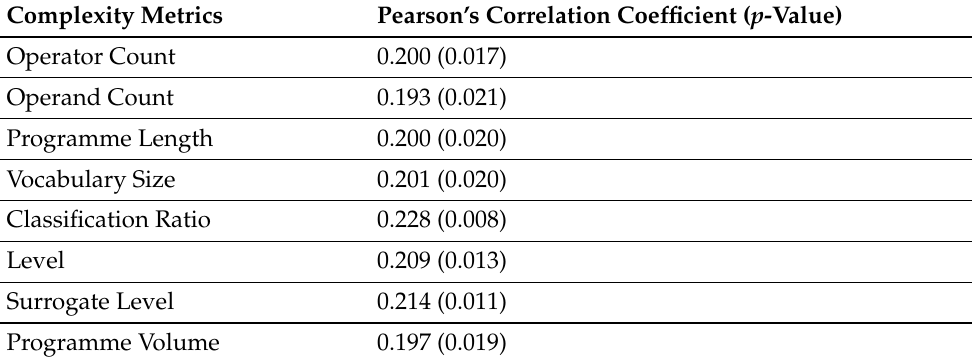
Table 3. Pearson’s correlation coefficients (p-values) for Halstead-based complexity metrics and the response